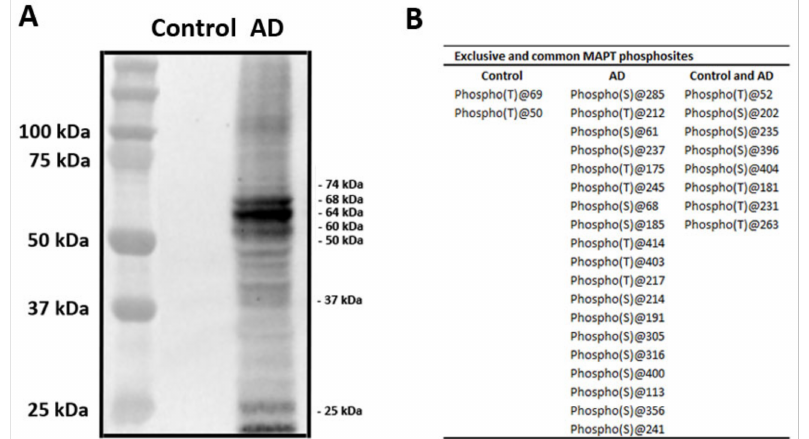
Figure 3. Characteristics of sarkosyl-insoluble fractions. ( A ) Sarkosyl-insoluble fractions of AD brain homogenates blotted with anti-tauSer422 were characterized by three bands of 68 kDa, 64 kDa, and 60 kDa, a weak upper band of 73 kDa, and several lower bands of fragmented tau between 50 and 25 kDa. Lower bands stained with anti-tauSer422 show truncated tau at the C-terminal. Sarkosyl-insoluble fractions of the control case blotted with the same antibody are negative. The first lane on the left shows the molecular weight of the crude markers. ( B ) Table showing the phosphorylation sites in tau from sarkosyl-insoluble fractions of AD and control homogenates revealed by (phospho)proteomics. The phosphorylation site is labeled with T for threonine and S for serine. The table shows two phosphorylation sites in tau found only in the control; nineteen phosphorylation sites found only in AD; and eight phosphorylation sites which were common to control and AD. (phospho)proteomics was used to learn about the molecular composition of sarkosyl- insoluble fractions in AD and control cases. Twenty-seven phosphorylated tau sites were identified in AD, and ten phosphorylated tau sites in the control; eight phosphosites were shared by AD and control homogenates ( B